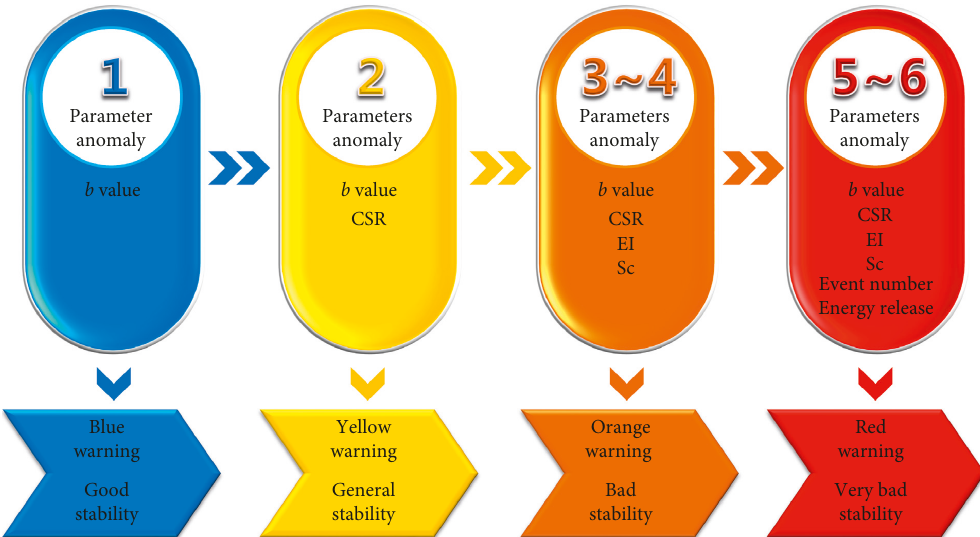
Figure 17: Method to discriminate the stability of